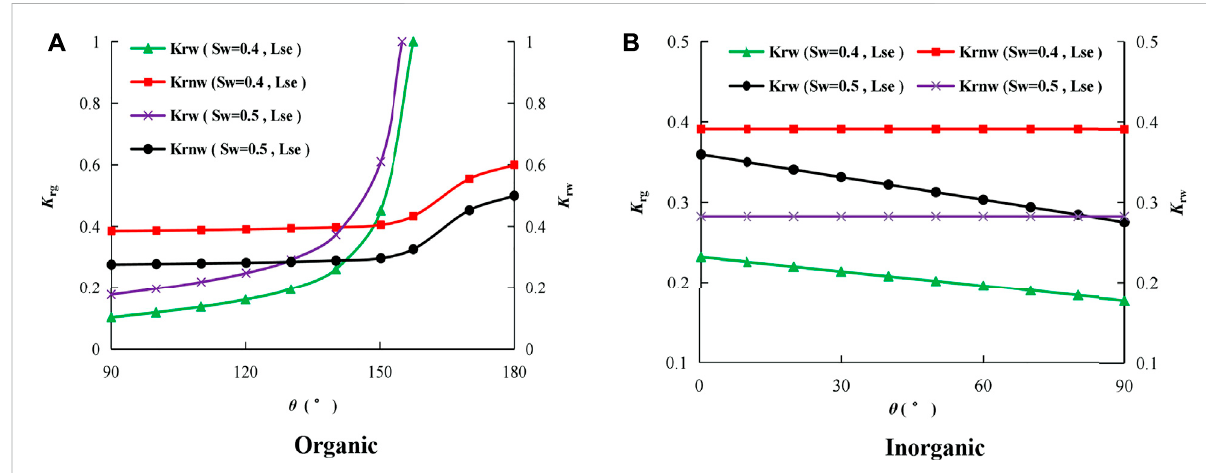
Effect of different wetting angles on the two-phase relative